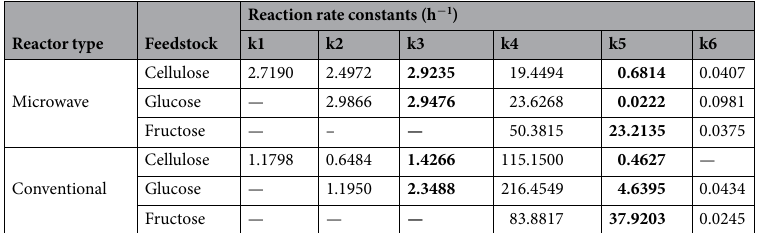
Table 2. Comparison of reaction rate constants between microwave and conventional (SiC) heating calculated by the 4 th order Runge-Kutta method. The cells with numbers in bold represent the rate constants involved in humin